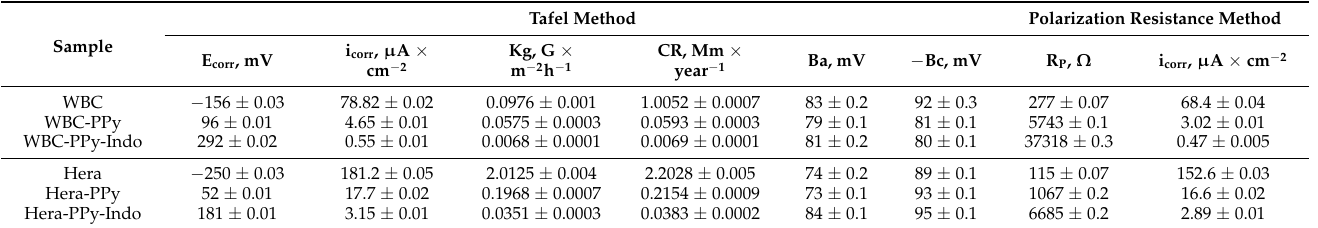
Table 4. Kinetic corrosion parameters for uncoated and PPy and PPy-Indo coated CoCr-based alloys in Tani-Zuchi artificial